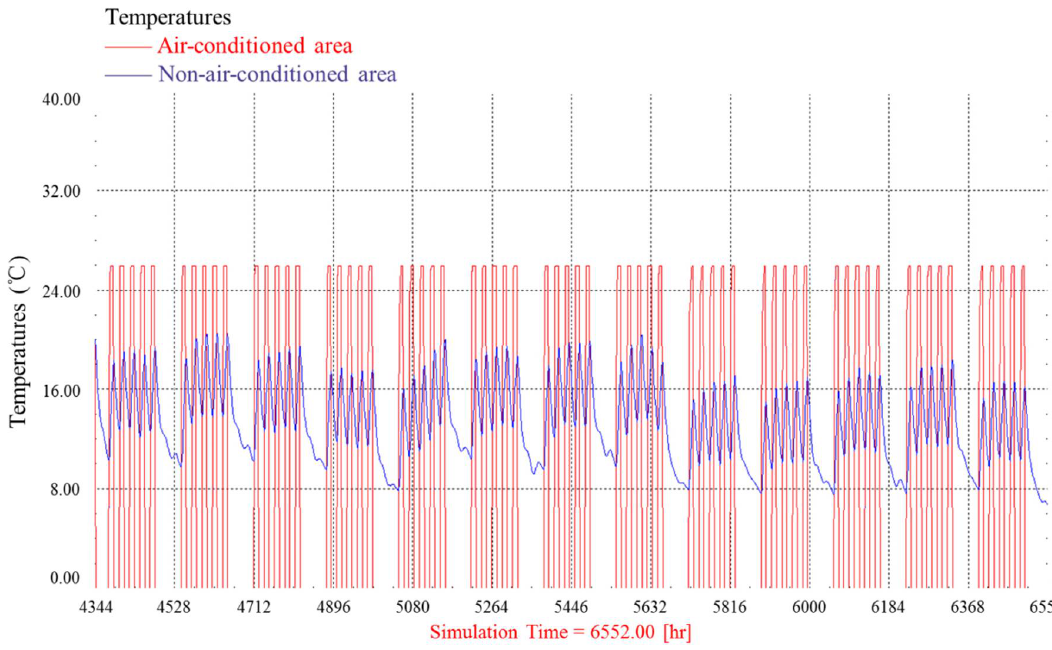
Figure 4. Temporary temperature change with cooling.